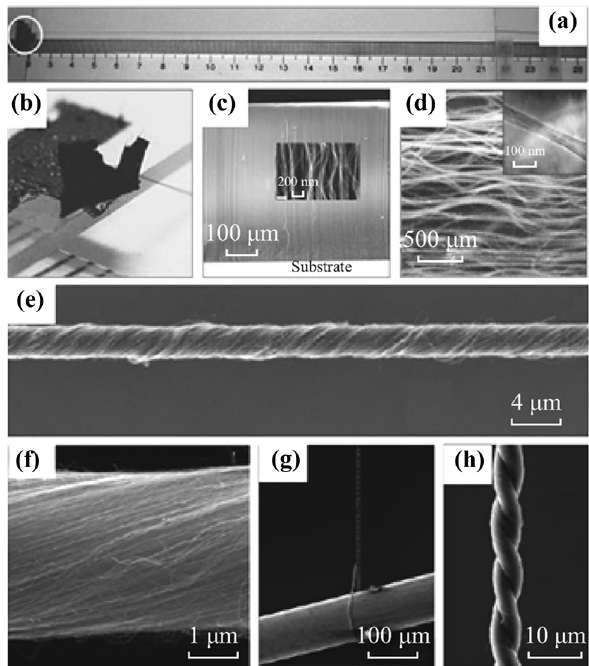
Fig. 5 a A CF pulled out from a freestanding CNT array, b magnified images and SEM images c of CNT array, d SEM image of the yarn of a , transmission electron microscope (TEM) image of a single thread of the CFs shown in inset, SEM images of CF at low e and high f magnification, g CF forming a loop around a Ni wire and then twisted, h SEM image of a two-ply twisted fiber. a – d